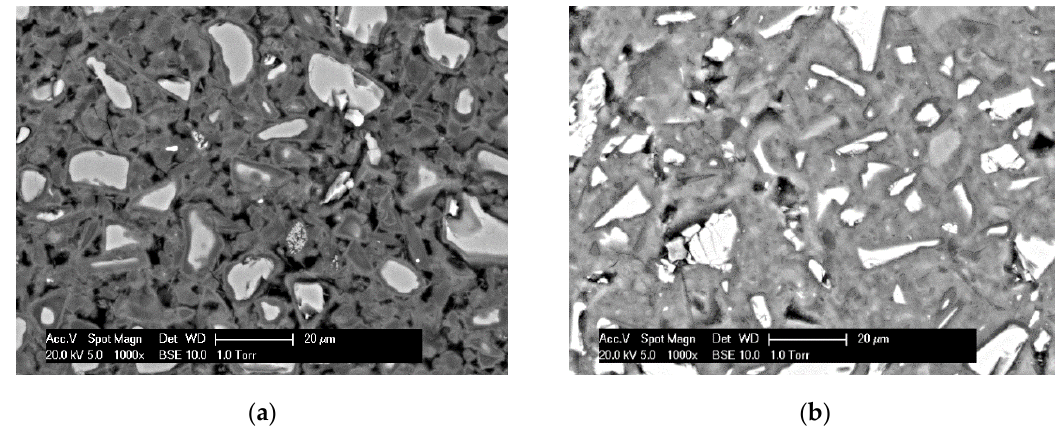
Figure 15. Micrographs, derived by SEM, for N4S0 ( a ) and N4S5.4 ( b ) at 28 days. N and S indicate weight percentages of Na 2 O and SiO 2 with respect to slag, respectively.